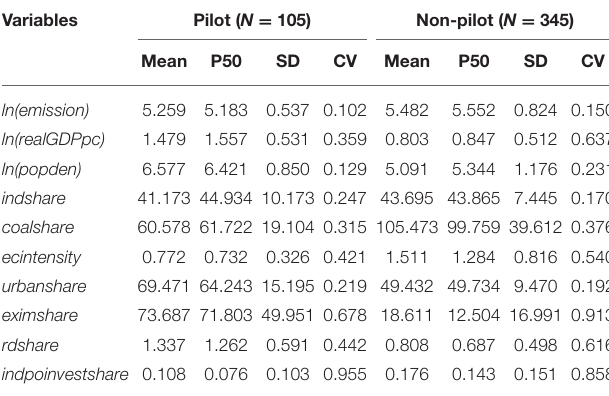
TABLE 3 | Descriptive statistics of variables by group. TABLE 4 | Probit